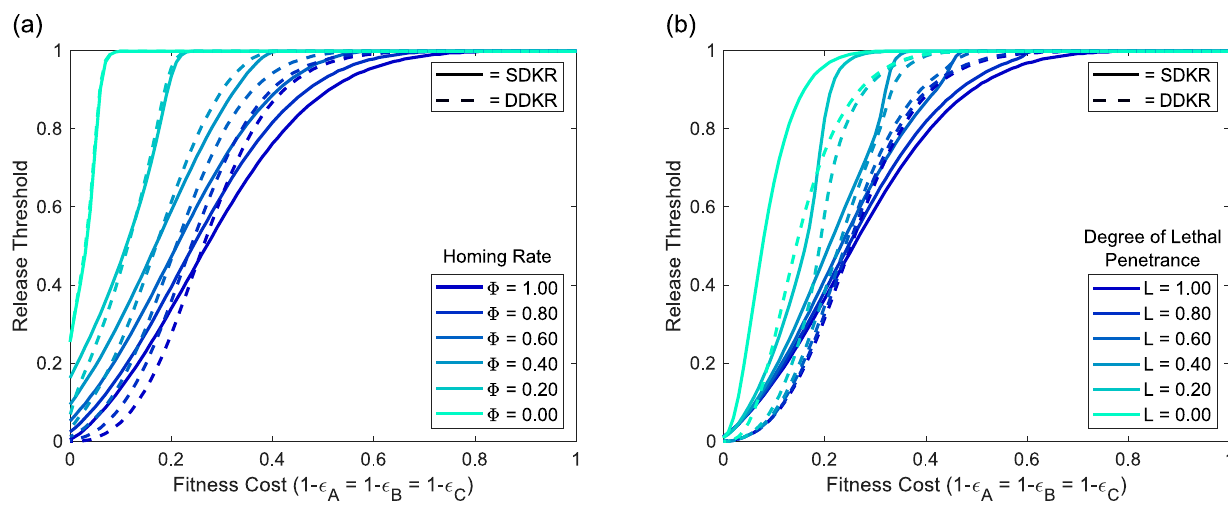
Figure 8. A comparison of required introduction thresholds for SDKR and DDKR. ( a ) Threshold introduction frequencies for SDKR (solid lines) and DDKR (dashed lines) under a range of different rates of homing ( (cid:31) ). ( b ) Threshold introduction frequencies for SDKR (solid lines) and DDKR (dashed lines) for a range of lethal penetrance ( L ) parameters. Line colours relate to the homing rate or degree of lethal penetrance considered with details given in the respective figure legends. Note that in each case we consider the release of individuals homozygous for both transgenic constructs and fitness costs that are applied